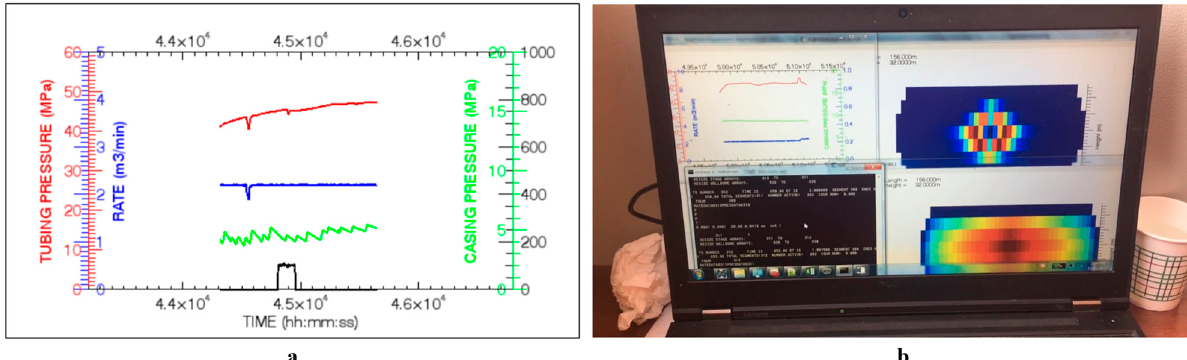
Figure 21. The real-time simulation of a slug of proppant. The photo was taken at Sulige gas field. ( a ) Data measured on the ground. The black curve is the real-time proppant concentration measured at the surface. Upper-left in ( b ) real-time downhole pressure calculated by FracCSM. Upper-right in ( b ): real-time proppant distribution inside the fracture predicted by FracCSM. Lower-right in ( b ): real-time width distribution inside the fracture predicted by FracCSM.